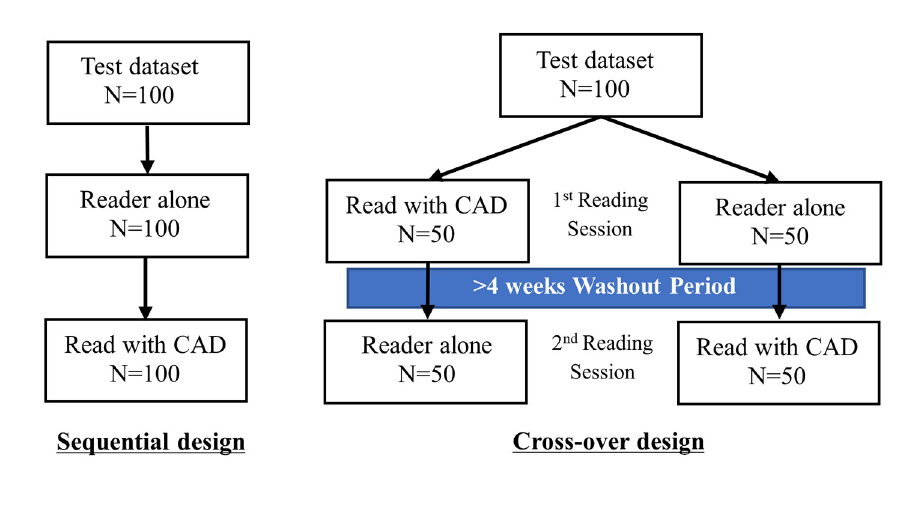
Fig 2. Overview of sequential design (left) and cross-over design